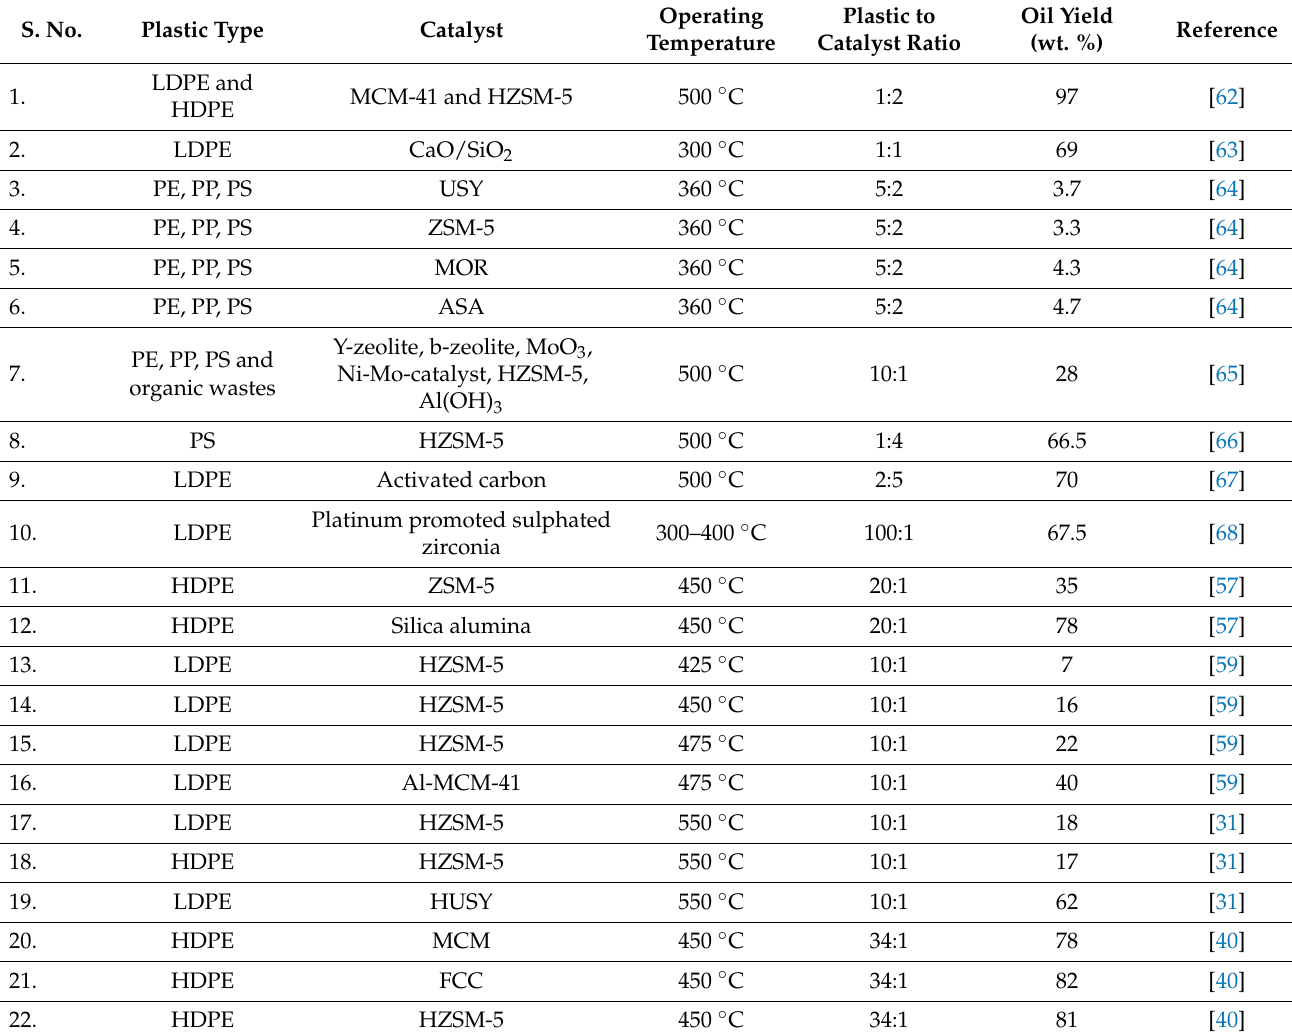
Table 3. Overview of catalyst and its interaction with different